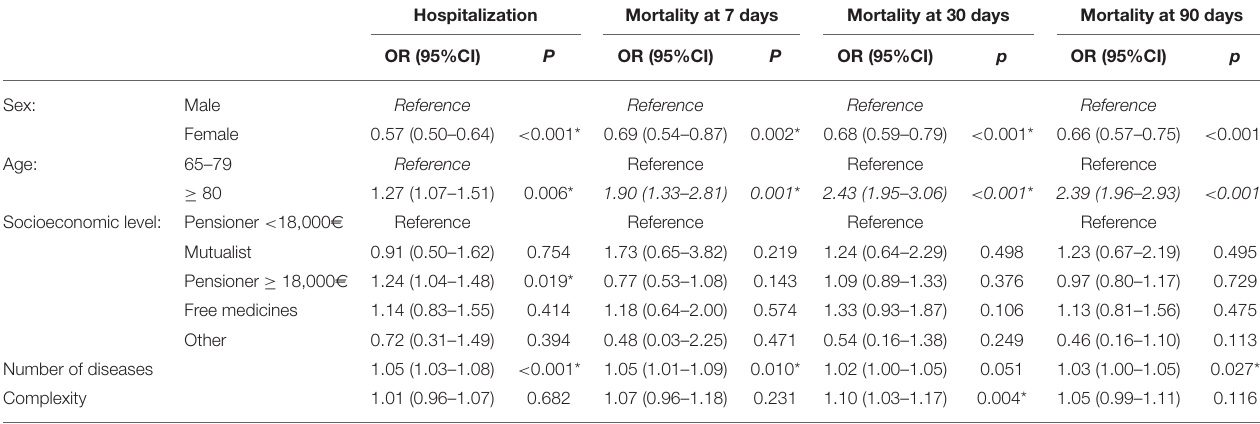
TABLE 4 | Sociodemographic and clinical factors associated with hospitalization and mortality in COVID-19 confirmed institutionalized patients over 64 years of age. Hospitalization Mortality at 7 days Mortality at 30 days Mortality at 90 days